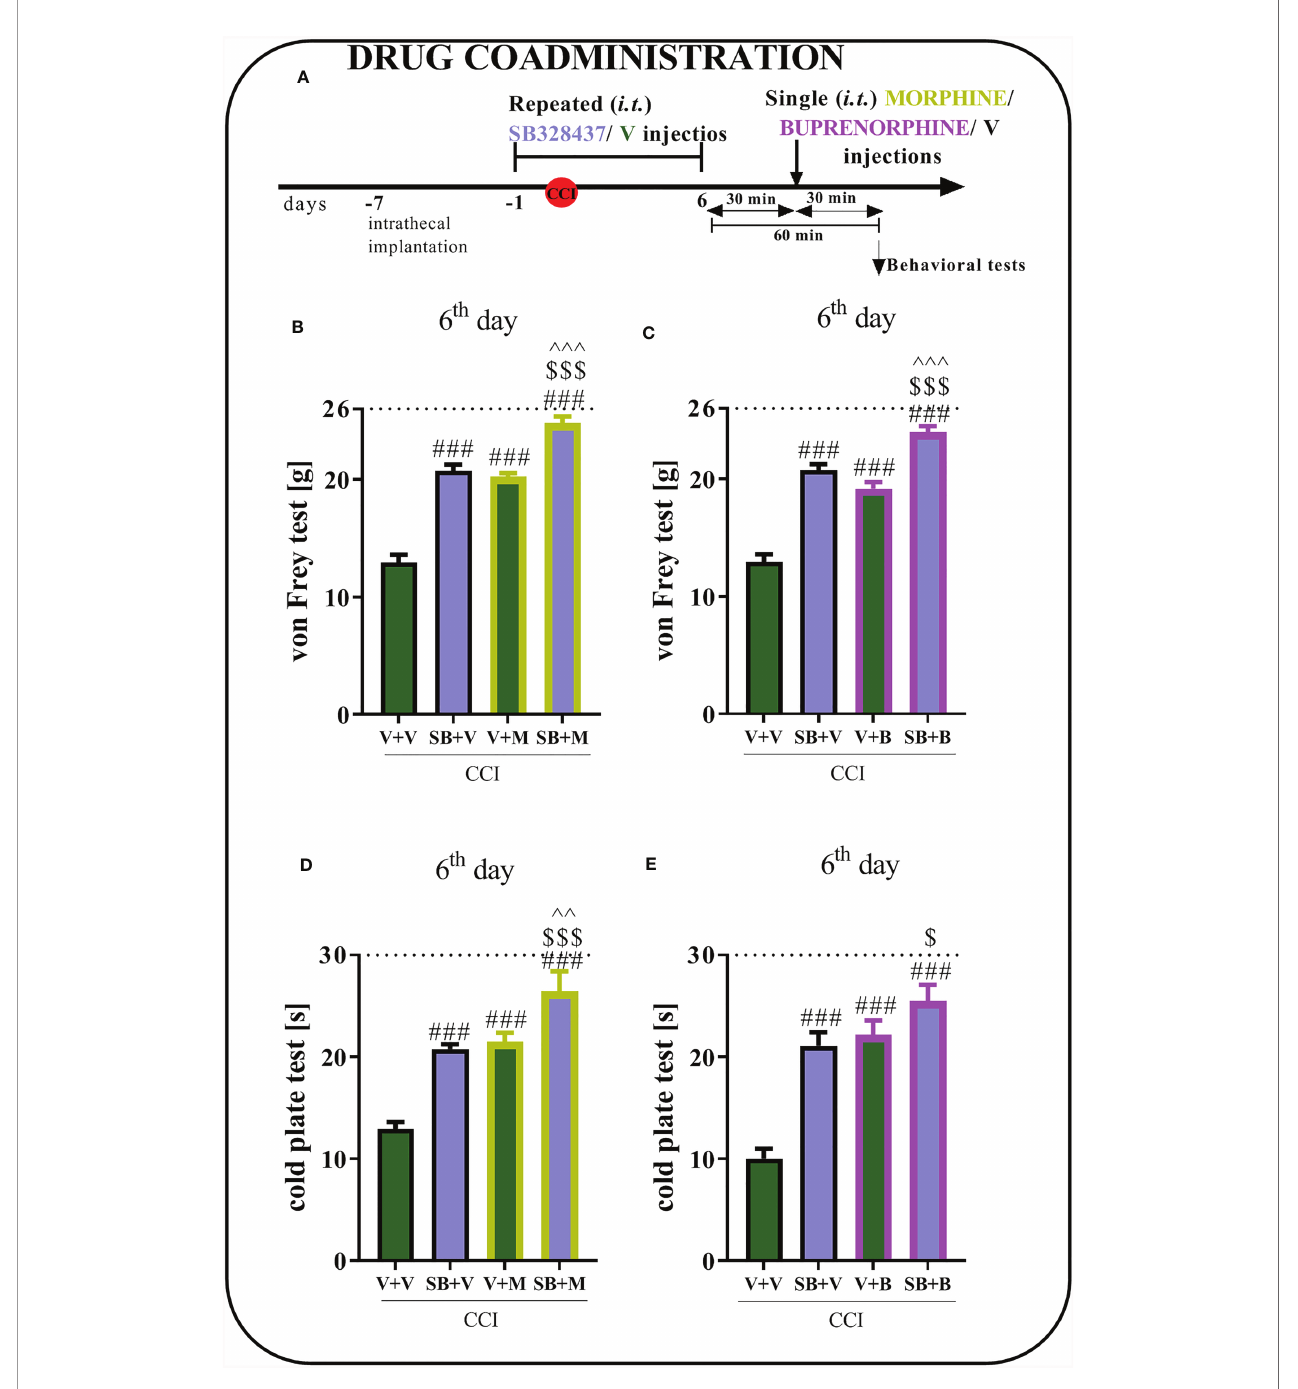
FIGURE 4 | Effect of repeated administration of SB328437 [SB, 10 m g/5 m l; i.t. (A) ] 16 h and 1 h before chronic constriction injury of the sciatic nerve (CCI) and then once a day for 6 days on pain-related behaviors in rats [von Frey test- (B, C) and cold plate test- (D, E) ] and the analgesic effects of morphine (M) [2.5 m g/5 m l, i.t ; (B, D) ] and buprenorphine (B) [1.0 m g/5 m l, i.t . (C, E) ] 1 h after SB or vehicle injections (30 min after opioids injections) on the 6 th day post-CCI. The data are presented as the means ± SEM of 5 – 7 rats per group. The horizontal dotted line shows the cutoff value. Intergroup differences were analyzed using ANOVA with Bonferroni ’ s post hoc test for multiple comparisons. ### P < 0.001 indicates a signi fi cant difference compared with the Vehicle (V)-treated group; $ P < 0.05 and $$$ P < 0.001 indicate a signi fi cant difference compared with the SB+V-treated group; ^^P < 0.01 and ^^^P < 0.001 indicate signi fi cant differences between the V+M- and SB+M-treated rats and between the V+B- and SB+B-treated